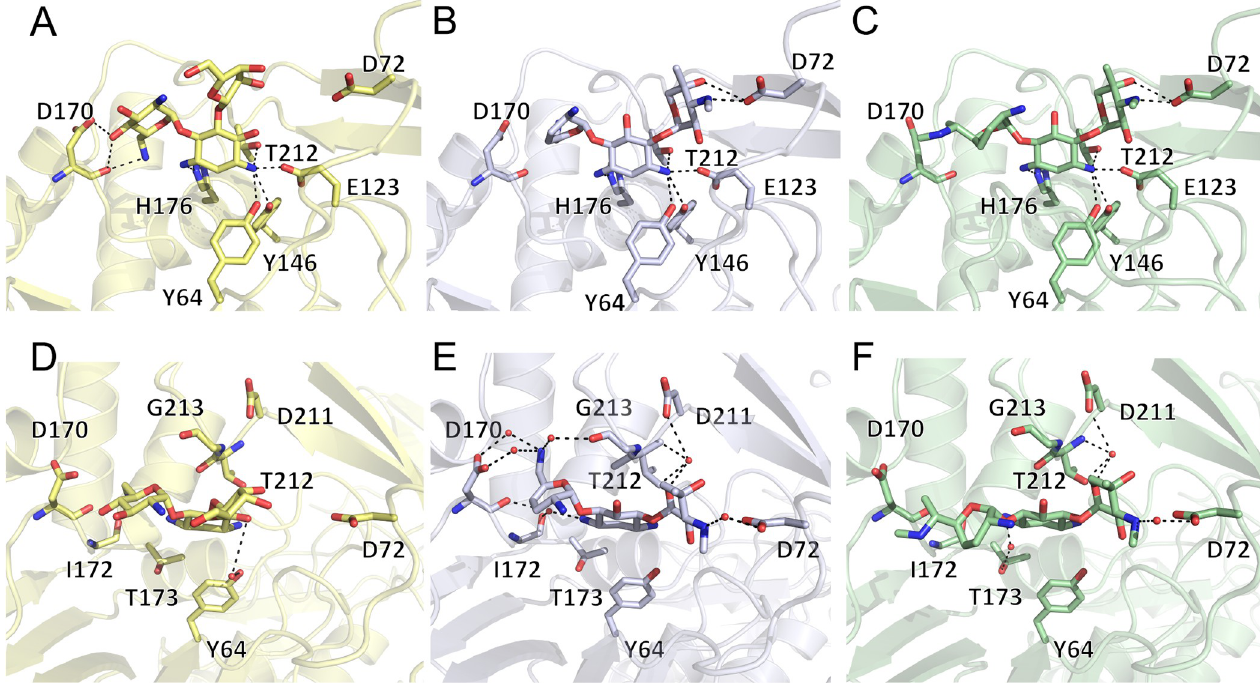
Fig 4. Representation of iso A binding to neomycin, sisomicin and gentamicin, in yellow, silver, and green, respectively. Panels A, B and C show direct hydrogen-bond interactions between the enzyme and aminoglycosides. Panels D, E and F show structures that have been rotated 90˚, to showcase water- mediated interactions between the three aminoglycosides and